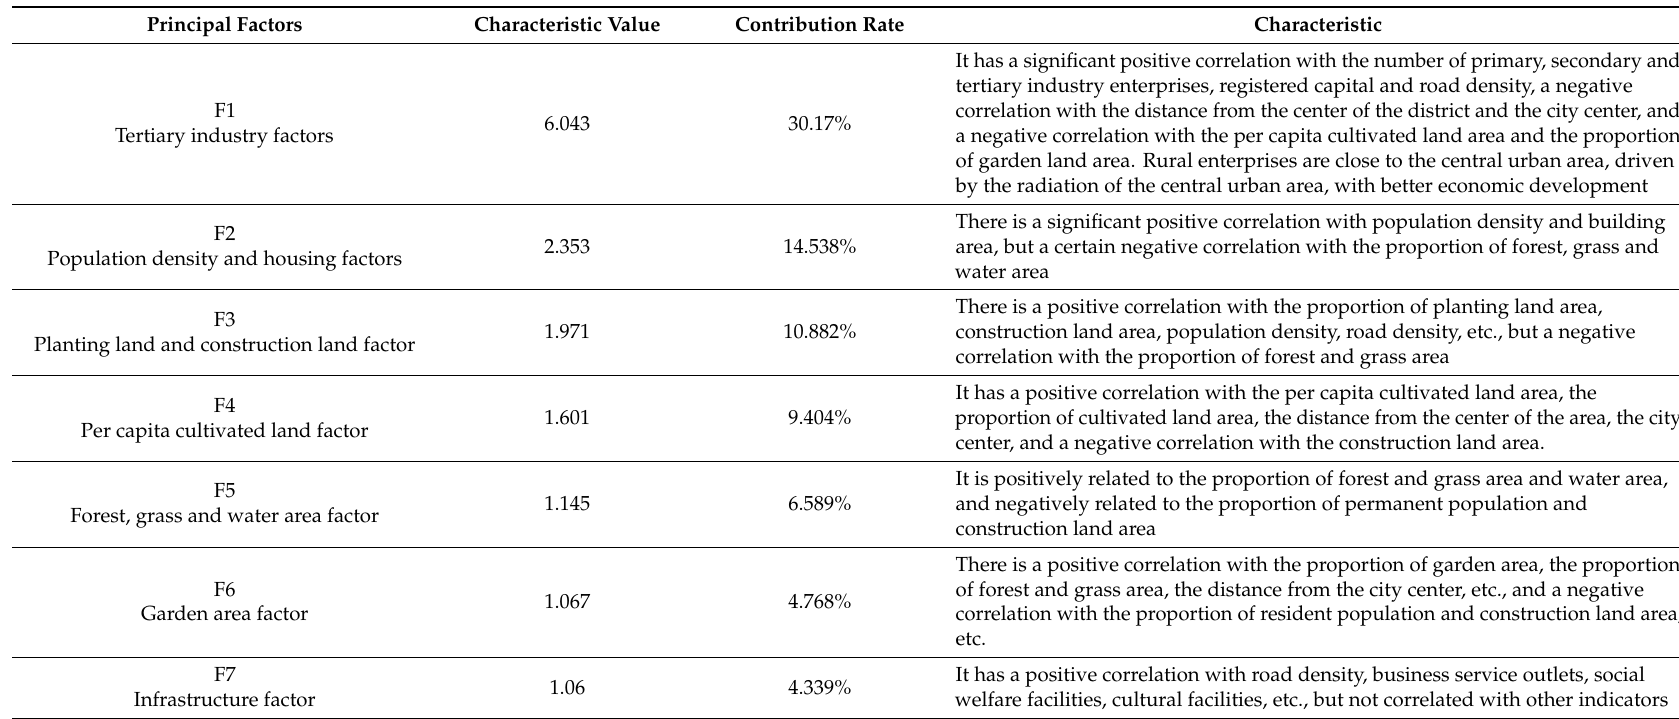
Table 3. Principal factor analysis of rural development in administrative villages of Wuhan City’s new urban districts in